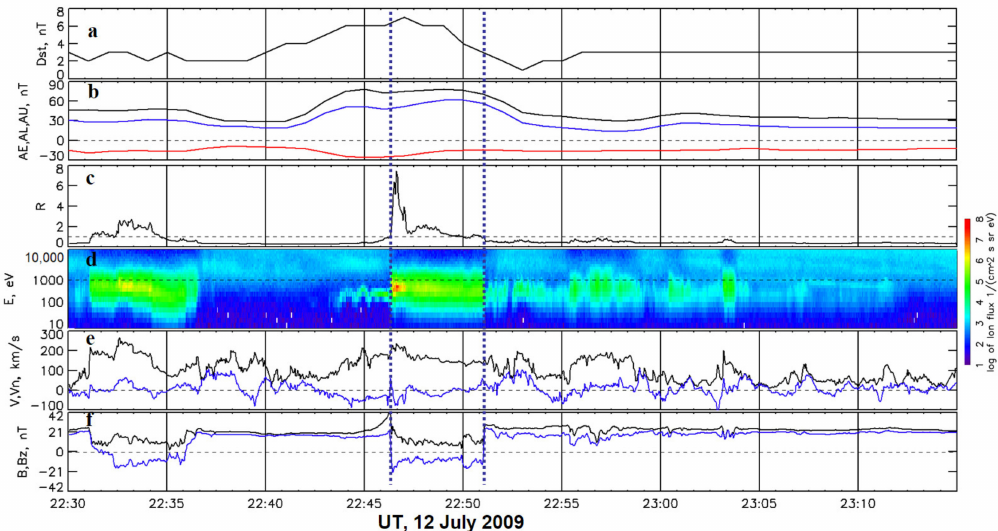
Figure 2. Magnetosheath plasma jets measured by THEMIS-C and geomagnetic perturbations observed from 2230 to 2300 UT on 12 July 2009: ( a ) Dst index; ( b ) auroral AE (black curve), AL (red curve) and AU (blue curve) indices; ( c ) ratio of total energy density measured downstream of the bow shock by THEMIS-C and upstream by ACE; ( d ) ion spectra measured by THEMIS-C; ( e ) THEMIS-C plasma velocity V (black curve) and normal to the magnetopause Vn (blue curve); ( f ) THEMIS-C magnetic field total B (black curve) and Bz component in GSM (blue curve). Jets were detected at 2231–2235 and 2246–2251 UT (indicated by vertical blue dotted